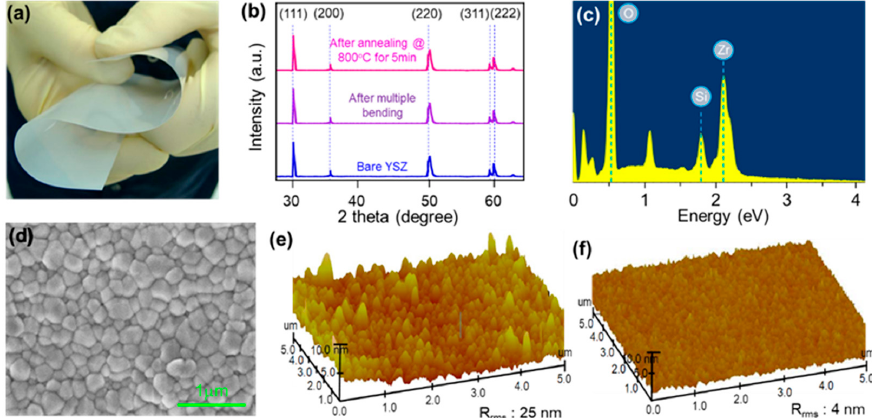
Figure 1. ( a ) a bent image of flexible Yttria-stabilized zirconia ceramic (YZS) substrate, ( b ), X-ray diffraction (XRD) spectra of a YZS substrate (red) a bare condition, (orange) after 20 times of bending, (blue) after the annealing at 800 °C for 5 min. ( c ) energy-dispersive X-ray spectroscopy (EDX) spectrum and ( d ) secondary electron microscopy (SEM) image of SiO 2 coated YZS substrate. Atomic force microscopy (AFM) images of ( e ) a bare YZS substrate, ( f ) a 50 nm thick SiO 2 coated YZS substrate.